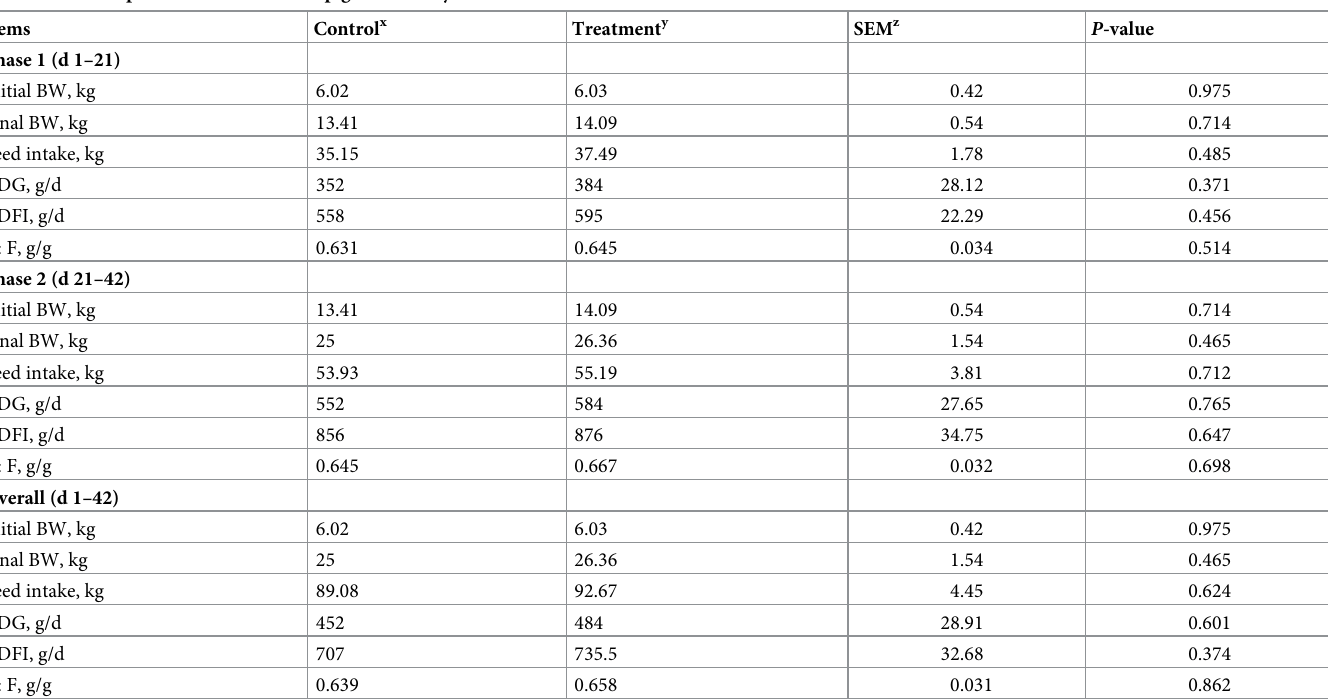
Table 5. Growth performance of weaned pigs fed dietary treatment 1 .